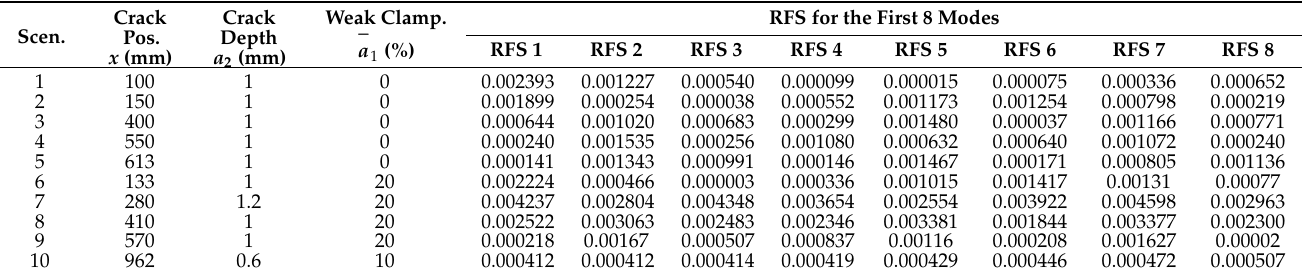
Table 4. Calculated RFS values for the defined damage scenarios.